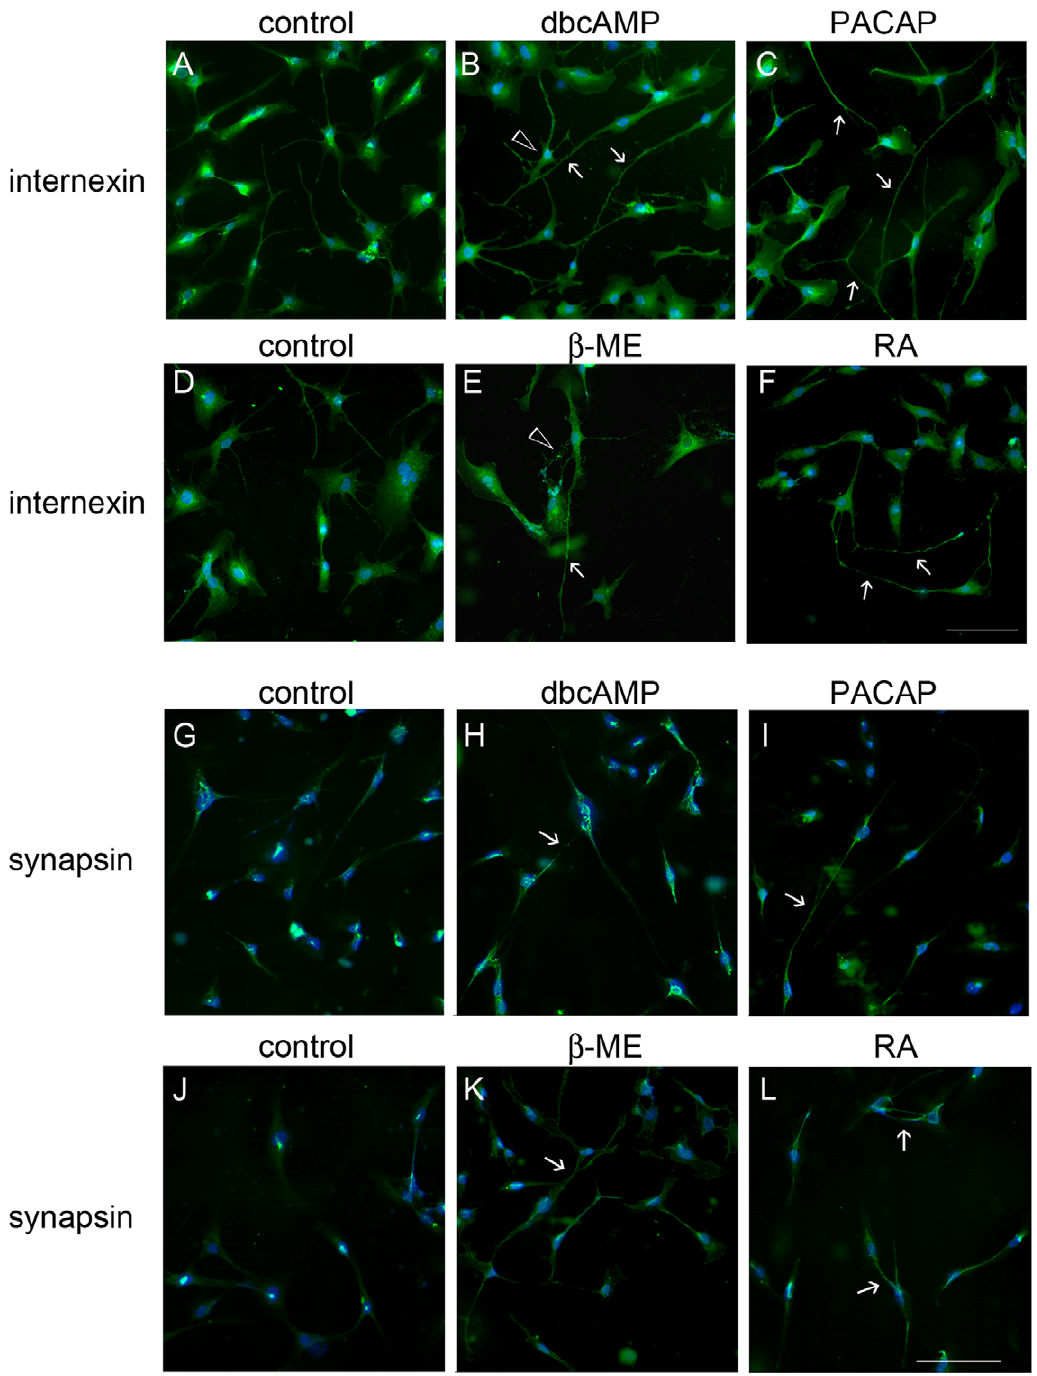
Figure 1. Neuronal-like transformation of immortalized hMSCs after treatment with neurogenic factors. The immortalized hMSCs were treated for 24 hours in serum-free ITS medium with several neurogenic factors, dbcAMP (0.1 mM), PACAP (20 ng/ml), b -mercaptoethanol ( b -ME; 1 mM), and retinoic acid (RA; 0.1 m M). The cultures were subjected to immunofluorescence staining for a -internexin (A–F) or synapsin (G–L). Arrows and arrowheads indicate elongation and branching of the processes in hMSCs, respectively. Scale bar in A–L, 100 m m.